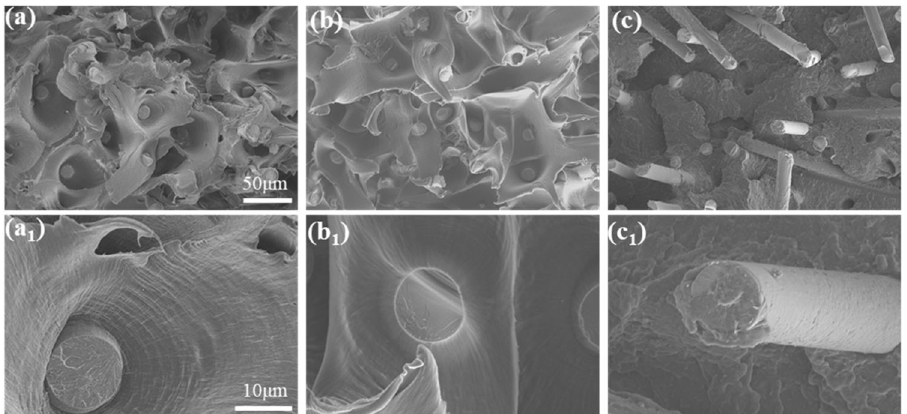
Fig. 8 SEM images illustrating the tensile-fractured surface of the GF23-PA12 sample. a Unaged sample, b 150 h-aged sample and c 700 h-aged sample.